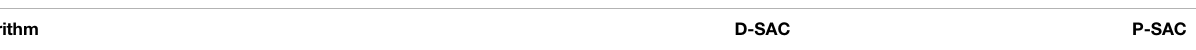
TABLE 5 | Final convergence value of D-SAC and P-SAC.